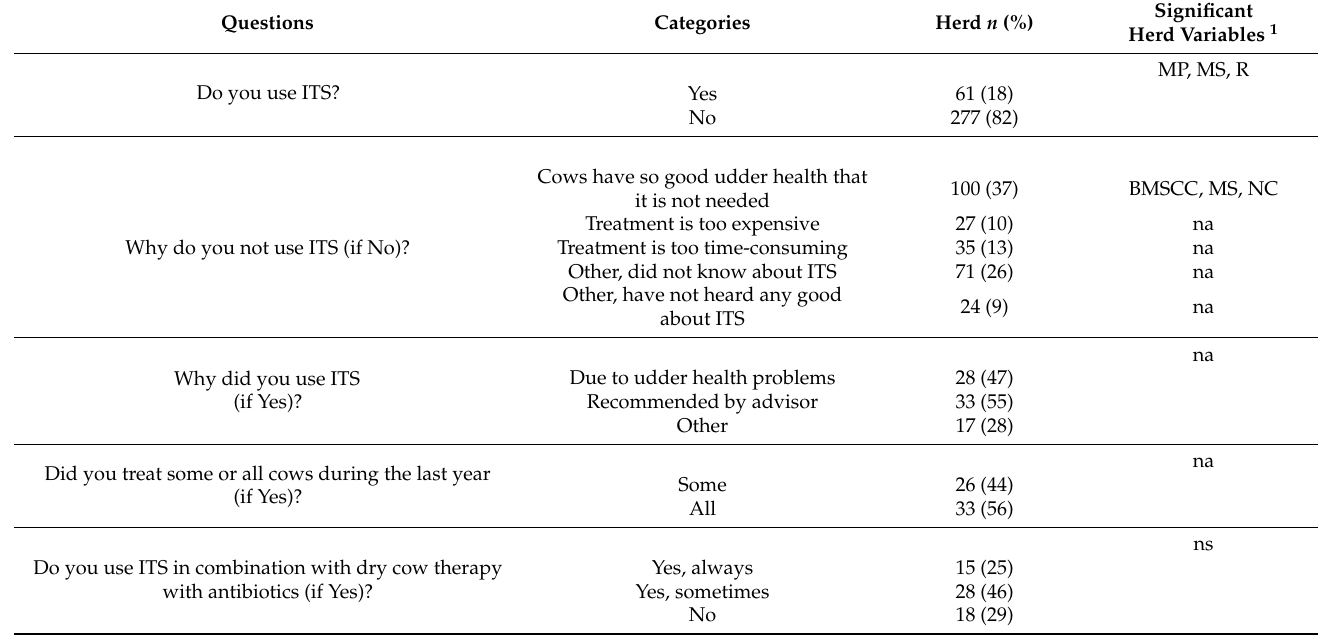
Table 5. Responses to questions about routines regarding treatment of dairy cows with internal teat sealants (ITS) at drying-off given by farmers ( n = 340) participating in a web-based questionnaire. The associations between herd variables and the answers were investigated using univariable regression models and if significant ( p ≤ 0.05) variables are